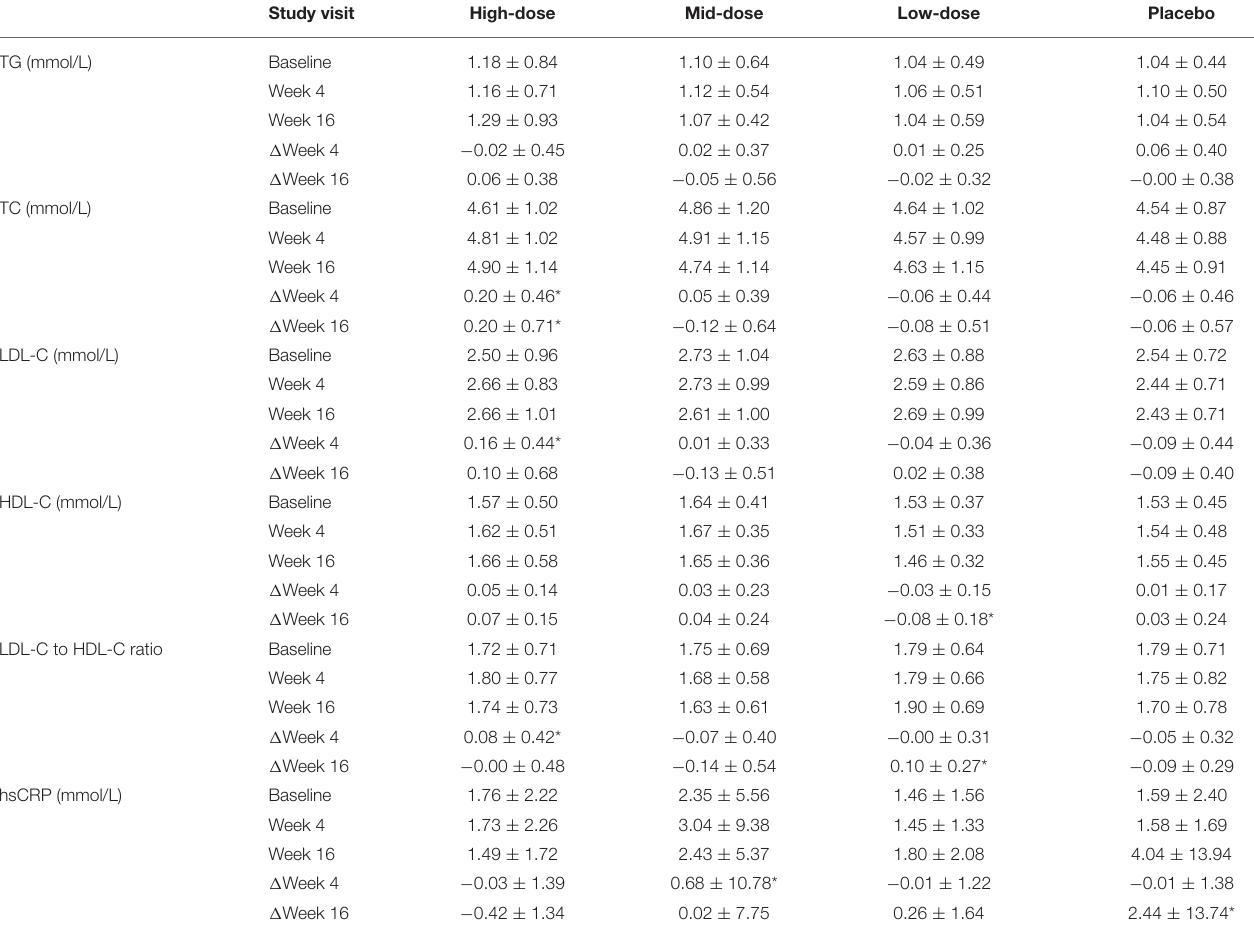
Values are means ± SD. The changes in serum cardiovascular biomarkers on the two different visits (4 and 16 weeks) were analyzed using an ANCOVA model with treatment, visit, smoking status, and interaction between treatment and visit (treatment × visit) as fixed effects, and the baseline parameter value as a covariate. P treatment , P visit , and P treatment × visit